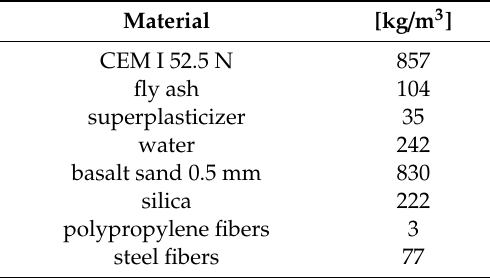
Table 2. Composition of the ultra-high performance concrete (UHPC)